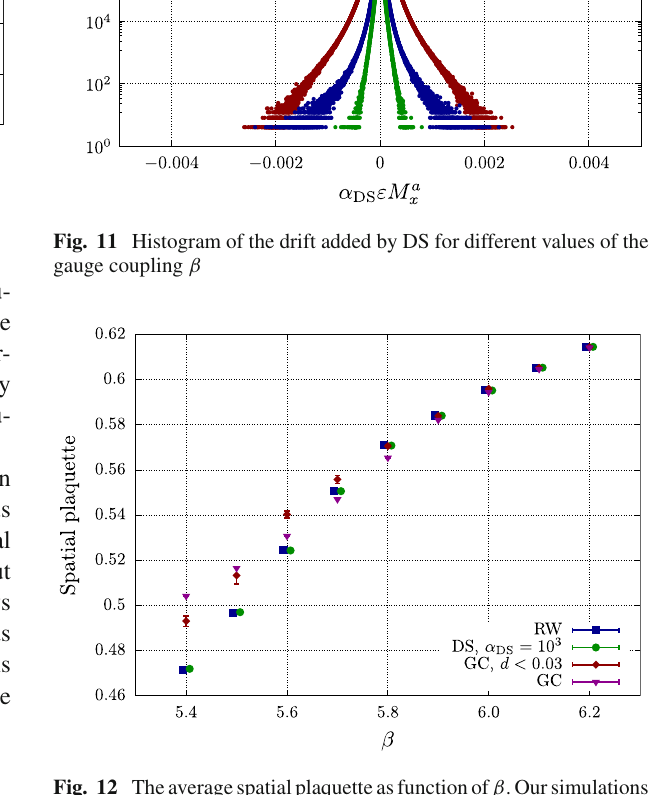
Fig. 12 Theaveragespatialplaquetteasfunctionof β .Oursimulations use a volume 6 3 × 6, μ = 0 . 85 and κ = 0 . 12. The data points